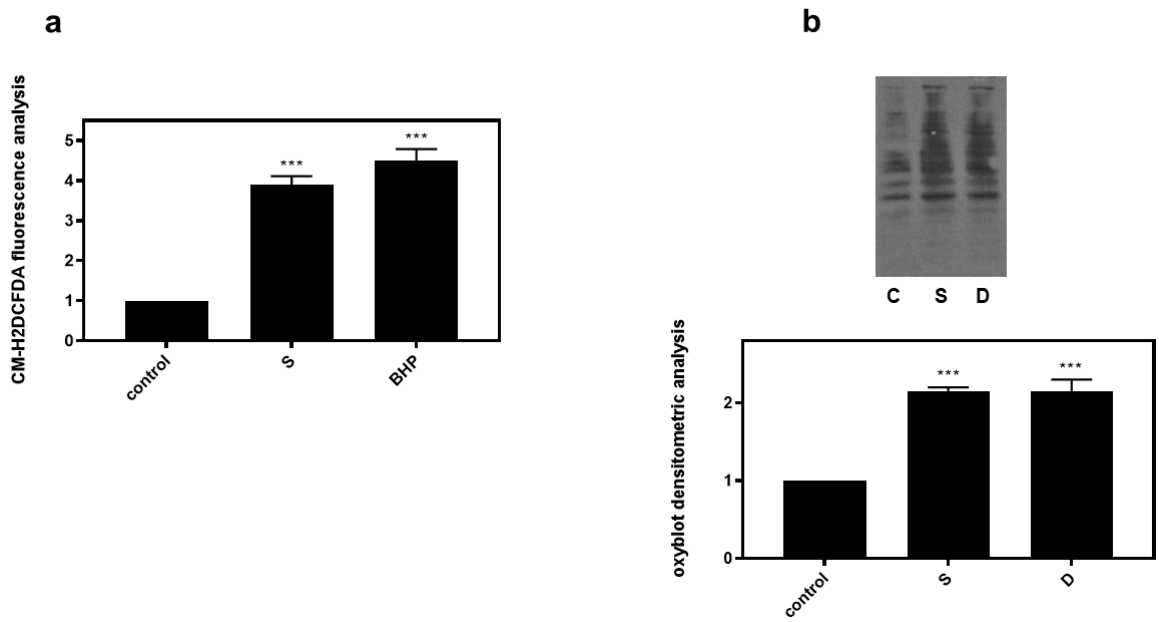
Figure 7. Hyperosmotic stress induces generation of ROS in H9c2 cardiac cells. H9c2 cells were exposed to 0.5 M sorbitol (S) or tBHP and were subsequently incubated with CM-H 2 DCFDA. After protein extraction the fluorescence intensity was measured in the homogenates ( a ). For oxyblot analysis H9c2 cells were exposed to 0.5 M sorbitol (S) or Diamide (D) and homogenized in RIPA buffer. Lysates were incubated with DNPH and proteins were electrophoresed (SDS-PAGE) and immunoblotted with an anti-DNP antibody ( b ). Immunoreactive bands were quantified by scanning densitometry and plotted (( b ) respective graph). Results are means ± SEM for at least three independent experiments. *** p < 0.001 compared to control values.